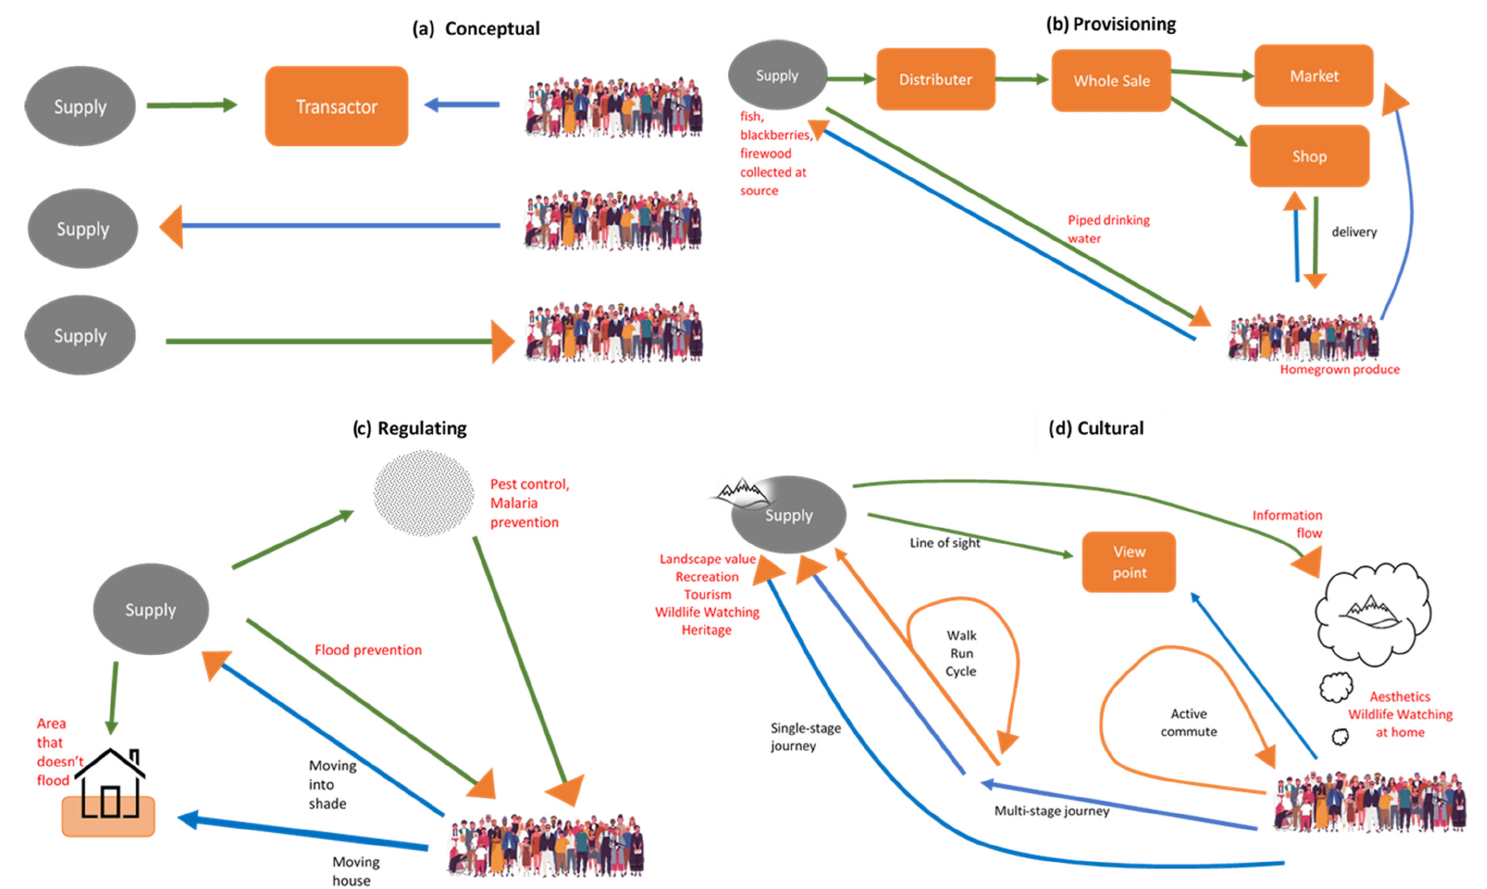
Figure 1. The flow of ecosystem services (ESs), conceptualised as two processes ( a ): nature to people (N2P; the movement of a natural good towards beneficiaries, shown in green) and people to nature (P2N; the movement of beneficiaries to a transactor in search of an ecosystem service, blue). Transactors, the point where the ES becomes realised, are shown in orange. Transactors are sometimes spatially distinct from the ecosystem and beneficiary (orange rectangles), but at other times the ‘transaction’ occurs in-situ (either at the ecosystem or beneficiary; orange arrowheads). Demand is shown via the group of people, with specific ES examples given in red. These processes occur across all ES categories: provisioning ( b ), regulating ( c ), and cultural ( d ). For example, drinking water flows down a mountain (N2P) and people go to the river to collect it (P2N). Sometimes P2N involves travelling all the way to the supply source, e.g., going to a forest to collect firewood, and sometimes N2P comes all the way to the demand, e.g., regulating services like pest